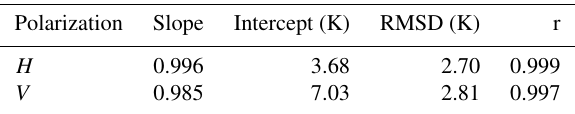
Table 2. Parameters for linear regression between SMOS and SMAP